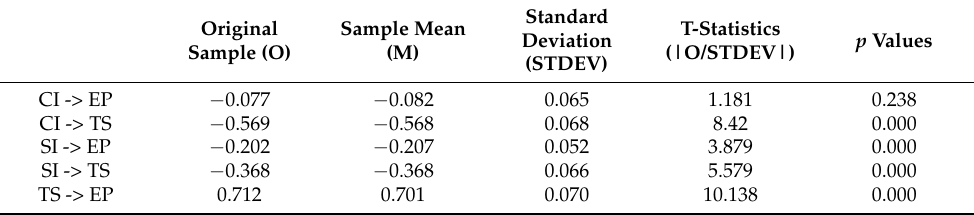
Table 6. Relationship of the